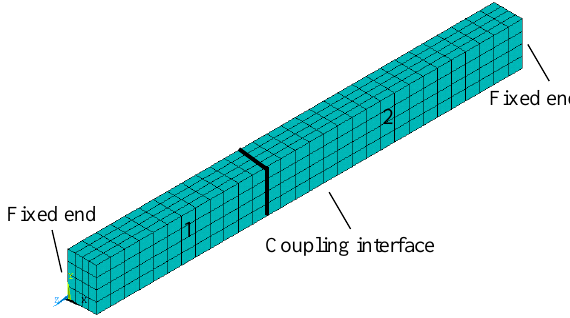
Figure 3. Finite element model of the beam with two ends